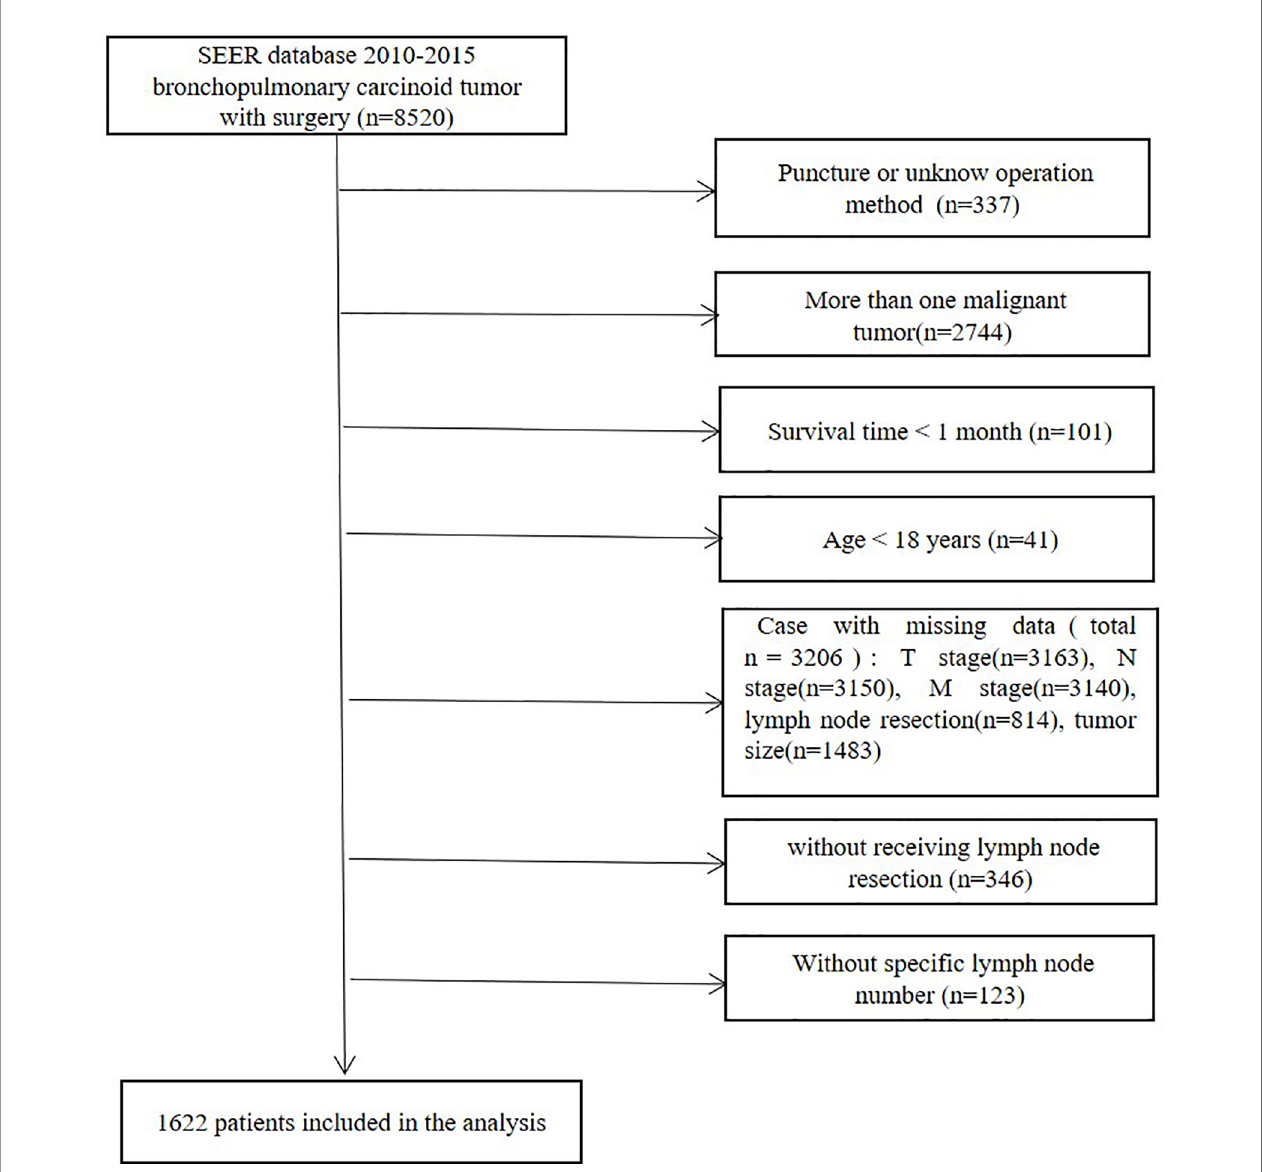
FIGURE 1 | Flow diagram for the selection of bronchopulmonary carcinoid tumors included in the fi nal analyses of this